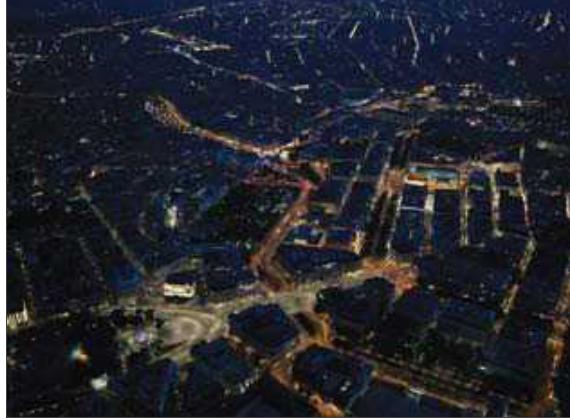
Fig. 2. View of Vienna centre 2007